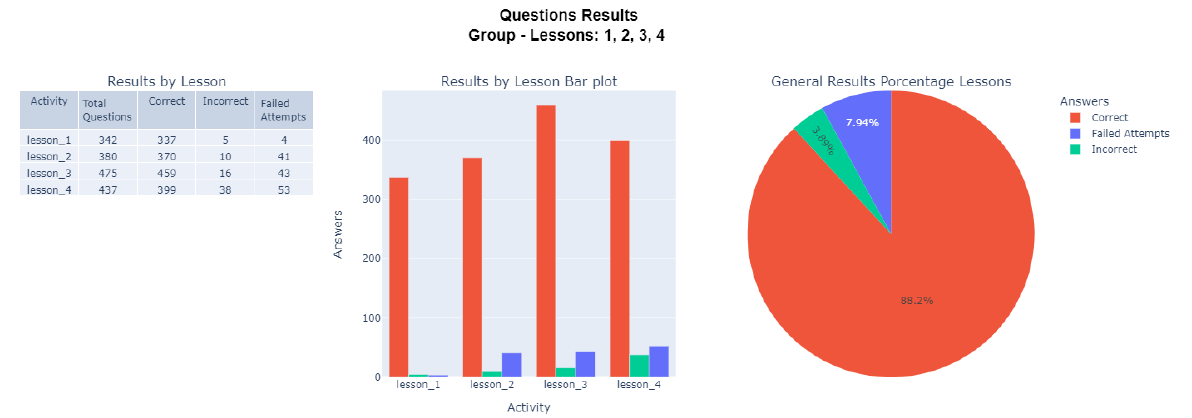
Figure 9. Group and lessons results.